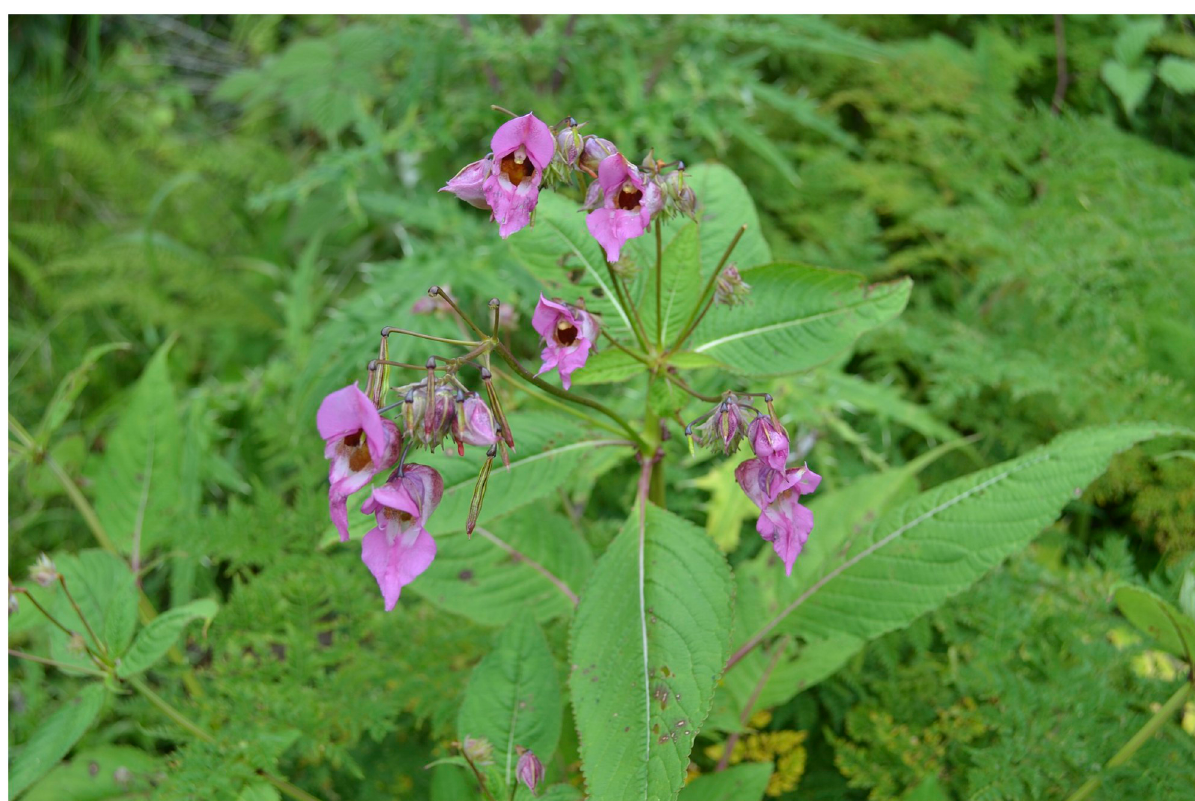
Fig 29. Impatiens sulcata (flowering plant). Photograph by Bhakta Bahadur Raskoti.